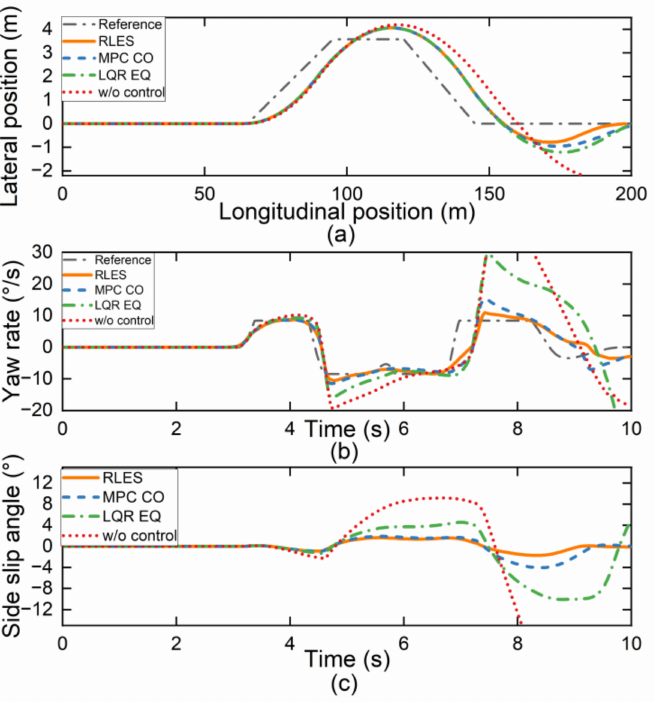
Figure 6. Simulation results on slippery road. ( a ) Vehicle displacement; ( b ) yaw rate; ( c ) side slip